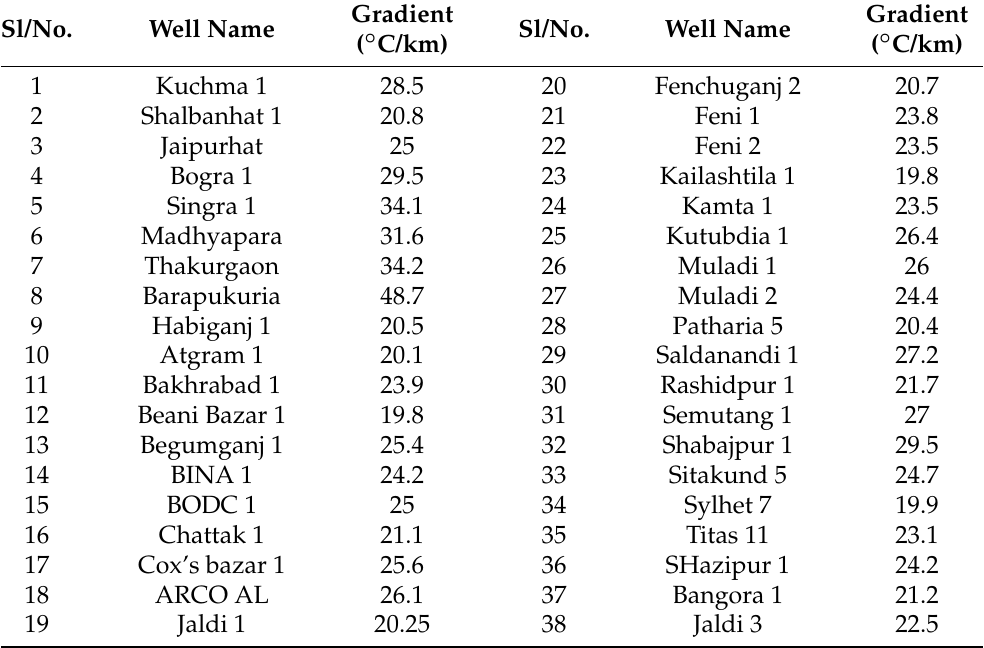
Table 7. The geothermal gradients of deep wells in Bangladesh [83,84].